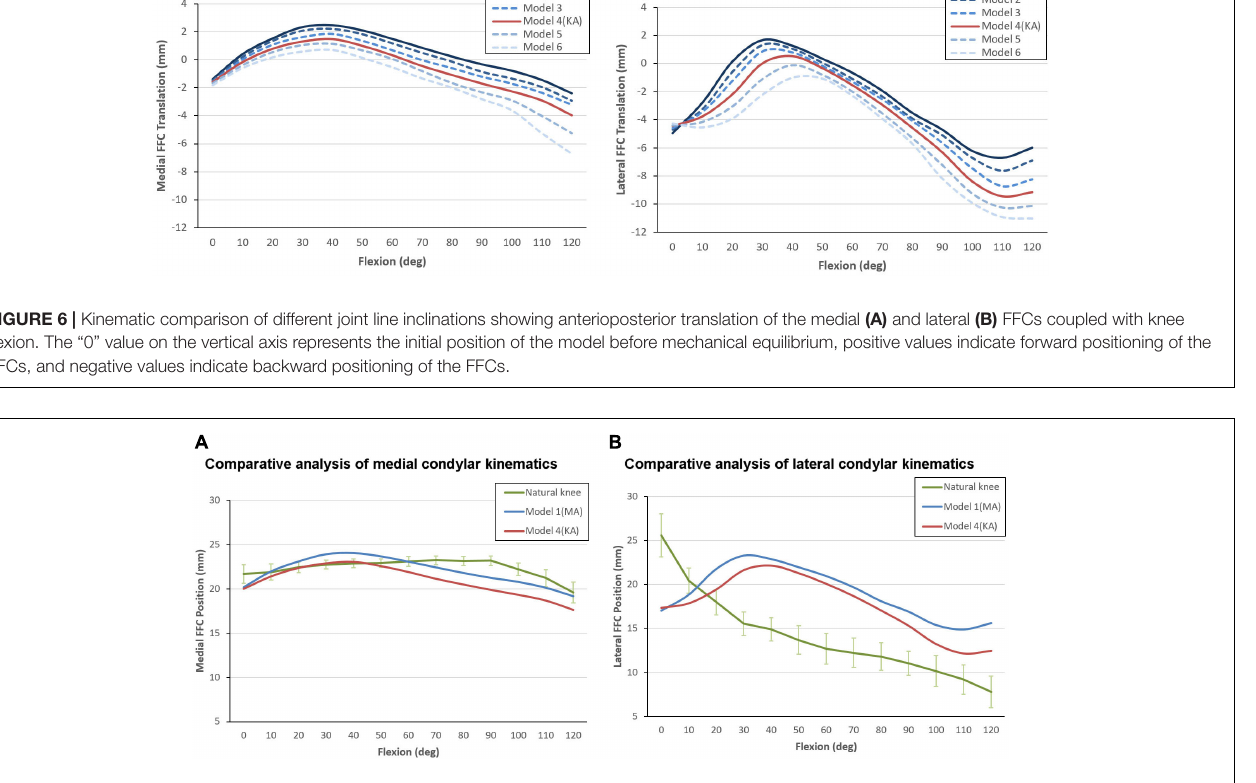
FIGURE 7 | Kinematic comparison between Model 1 (MA-TKA), Model 4 (KA-TKA) and the “living” knee (Johal et al., 2005). The motion curves of the medial FFCs (A) and lateral FFCs (B) were compared. The values on the vertical axis indicate the distance between the FFCs and the ipsilateral posterior edge of tibia condyles (for the natural knee), or the distance between the FFCs and the ipsilateral posterior edge of the polyethylene insert (for the